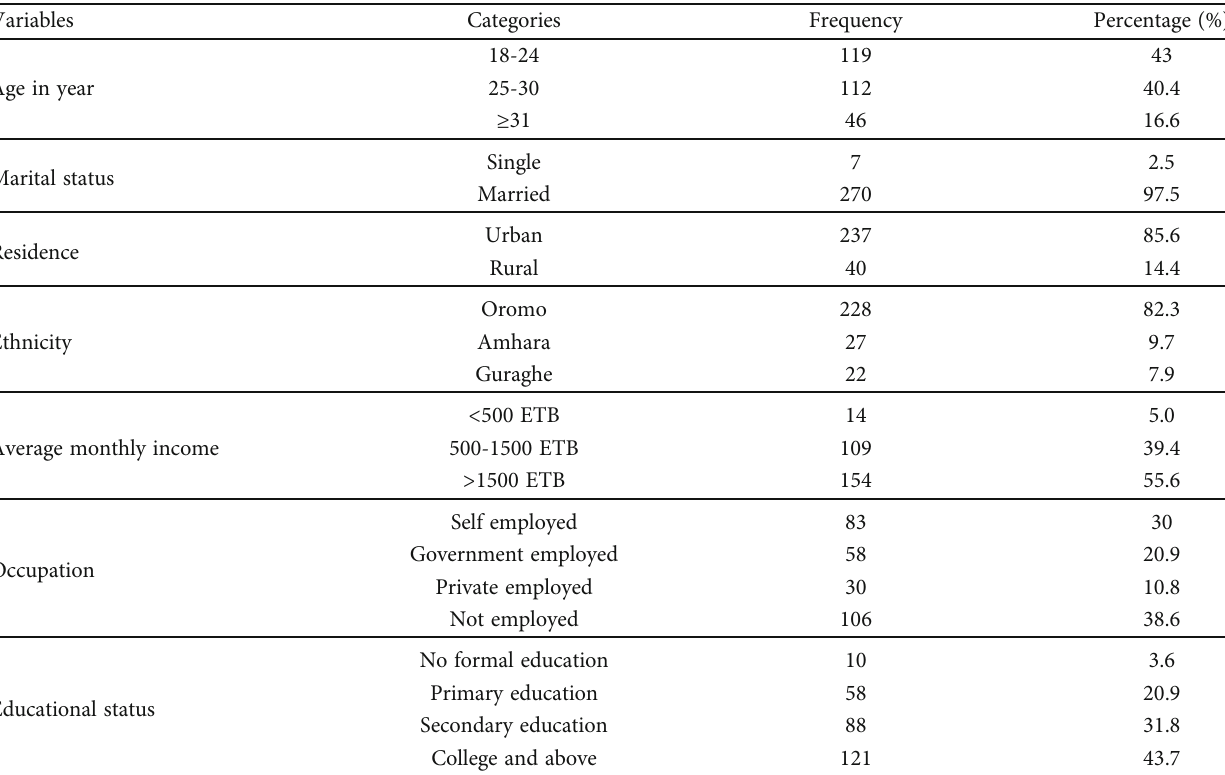
Table 1: Sociodemographic characteristics of pregnant women attending antenatal care at public health facilities in Nekemte town, Western Ethiopia, 2020 ( n = 277 ).